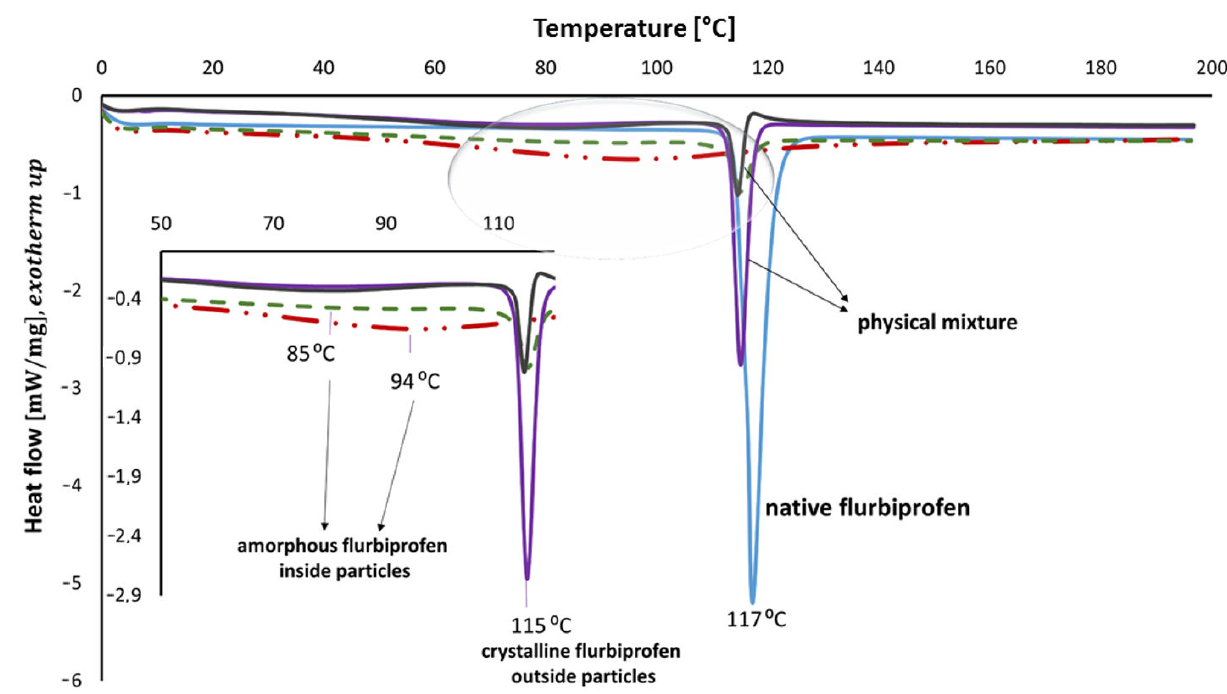
Figure 6. Illustration of DSC thermogram of native flurbiprofen (shows a sharp melting endothermic peak—blue line), flurbiprofen as a physical mixture with MCM-41 in 1:1 (violet line) and 3:1 (grey line) range and flurbiprofen loaded into MCM-41 1:1 (green line) and 3:1 (red line); flurbiprofen in the pores of carrier melt lower and the melting is observed in a wider temperature range to the native form. Data provided courtesy of Katarzyna